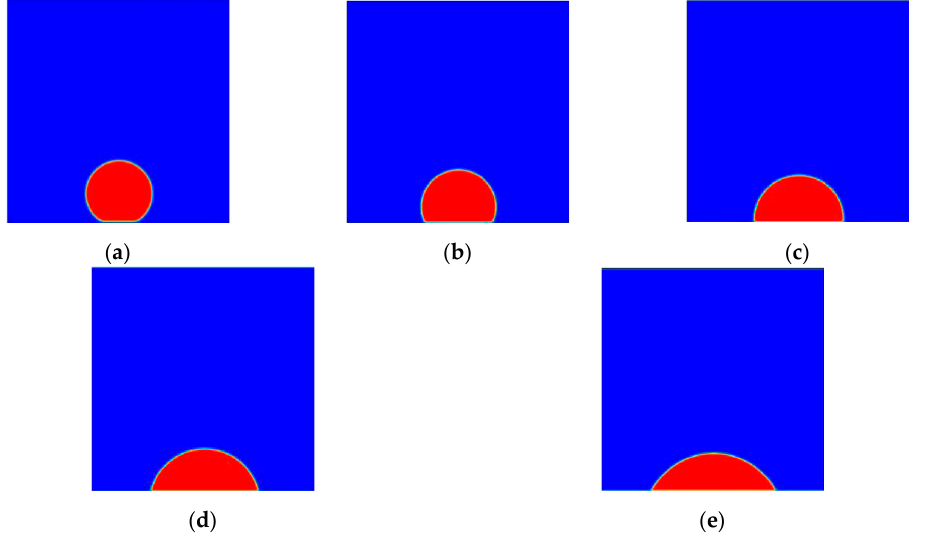
Figure 6. The wall wettabilities. ( a ) θ = 148.7°; ( b ) θ = 115.9°; ( c ) θ = 92.6°; ( d ) θ = 76.0°; ( e ) θ = 61.9°. Table 1. Relationship between the contact angle and the wall density.